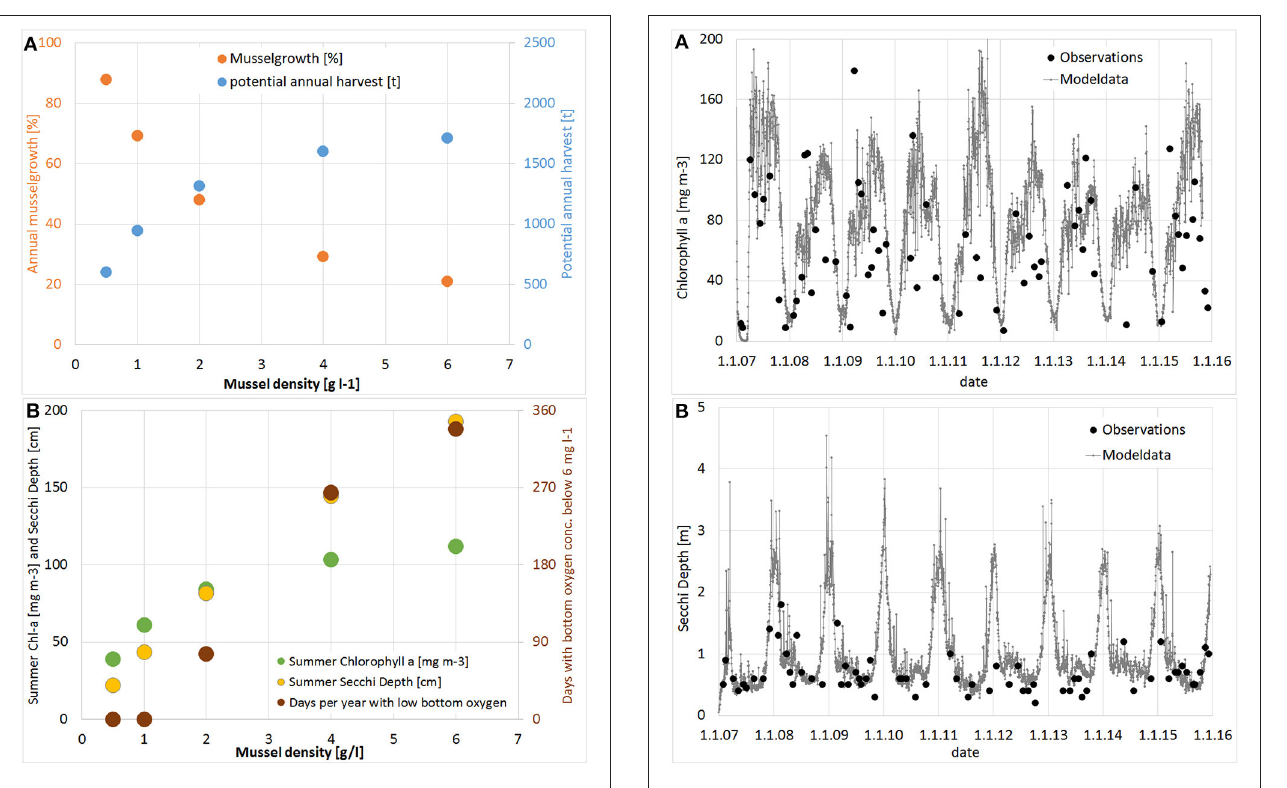
FIGURE 4 | (A) Change of annual potential harvest [t a − 1 ; blue] and mussel growth (harvest divided by mussel biomass; orange); (B) decrease of Summer Chlorophyll a [mg m − 3 ; green] and increase of Secchi Depth [cm; yellow] and days per year with bottom oxygen concentration below 6mg l − 1 [brown] compared to the simulation without mussels for different mussel densities in Lake Usedom.